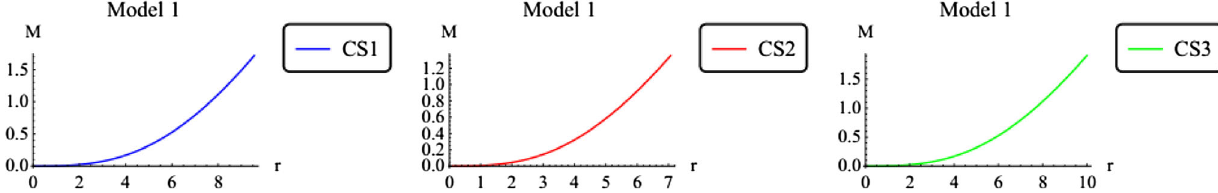
Fig. 15 Variations of the mass function for different charged compact stars